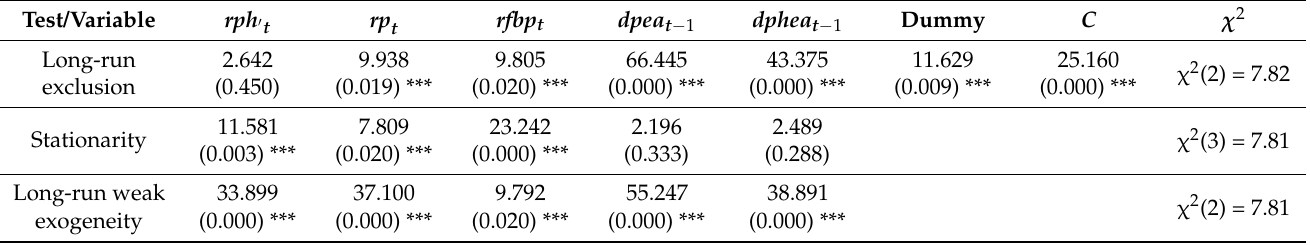
Table 3. Test of hypotheses on properties of the system variables ( r =